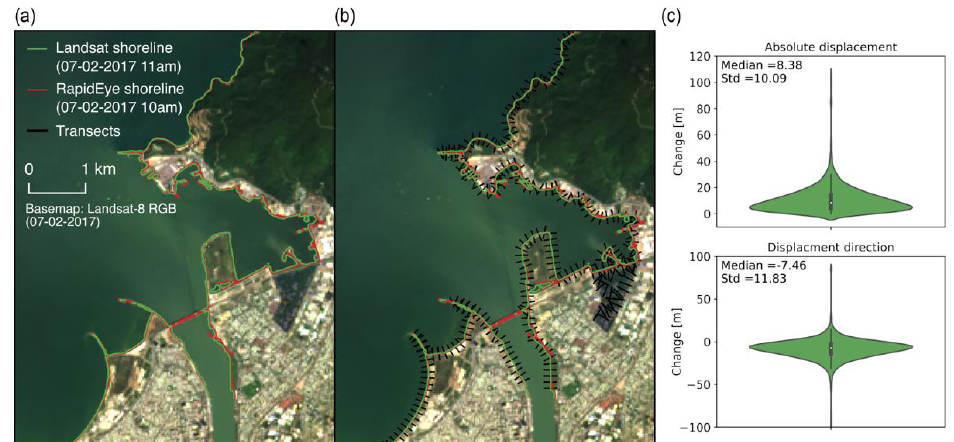
Figure 10. ( a ) Cutout of the manually digitized RapidEye reference shoreline (red) and automatically extracted Landsat shoreline (green). ( b ) Shore-perpendicular transects along which the displacement is calculated. ( c ) Distribution of displacement values between both shorelines showing absolute displacement vs. displacement direction (positive: towards land; negative: towards the sea).